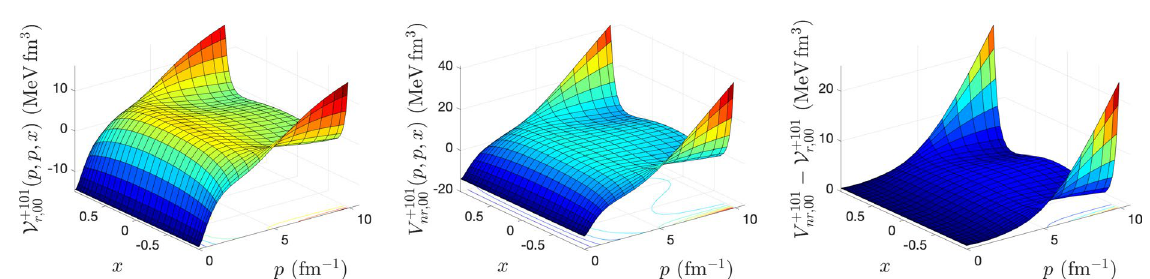
p ′ and the cosine of the angle between them x . =